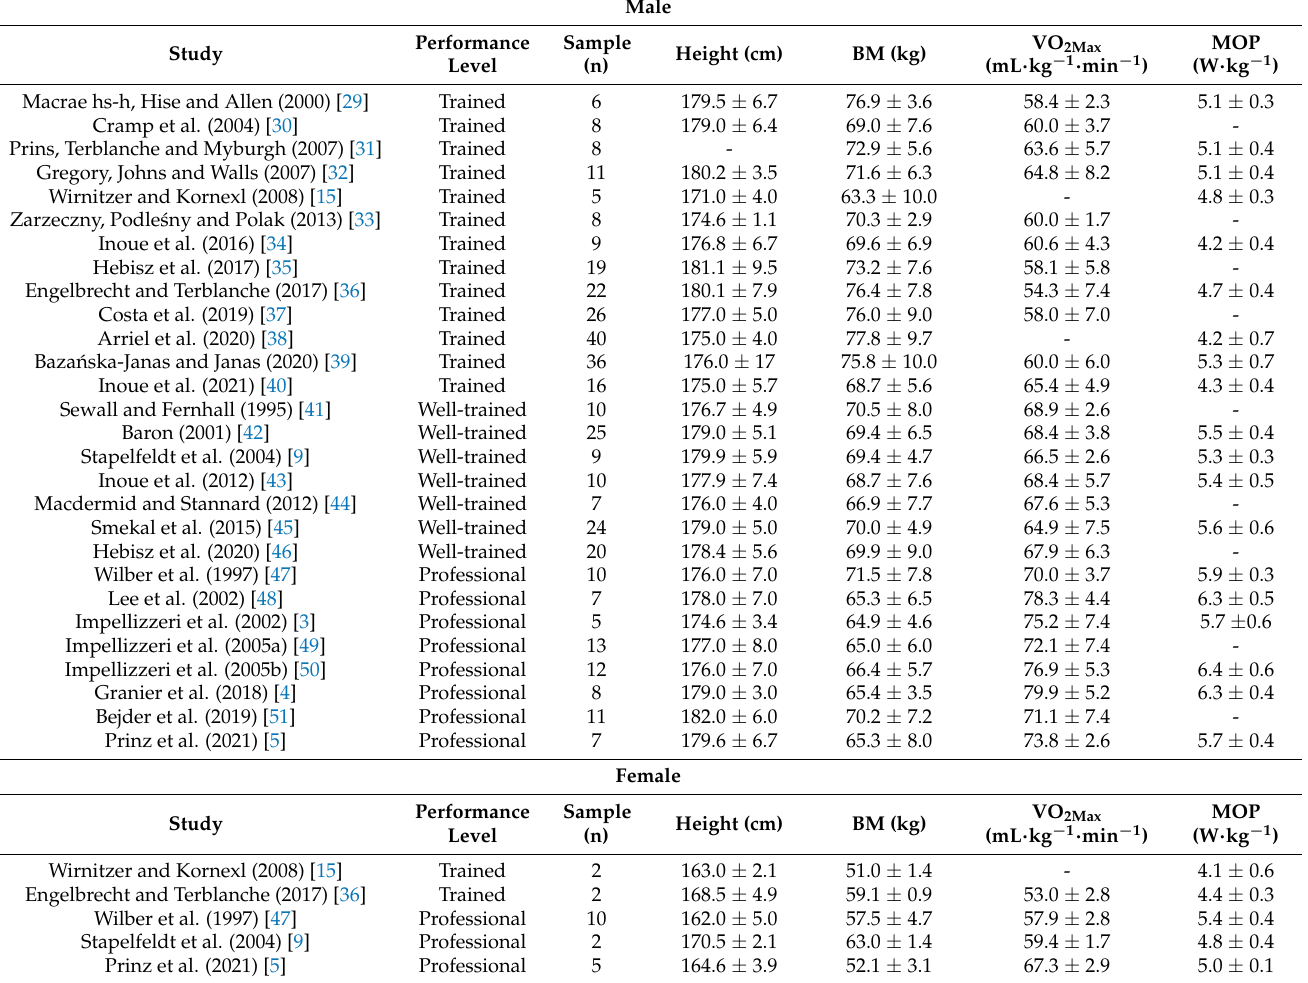
Table 4. Anthropometric and physiological profile of the cyclists according to performance level and